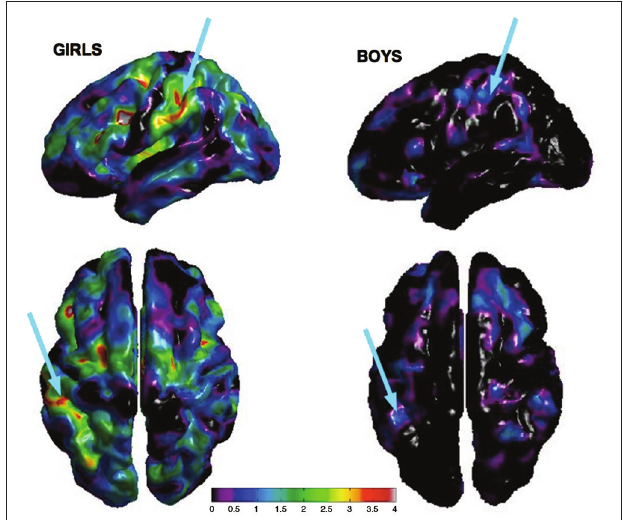
FIGURE 2 | Cortical thickness maps of bilateral IPS showing peak correlation between performance on the transposed melody task and CT at Time 4 for girls (left) and boys (right) separately . Arrows show peak correlation in left IPS from both a lateral and dorsal angle.